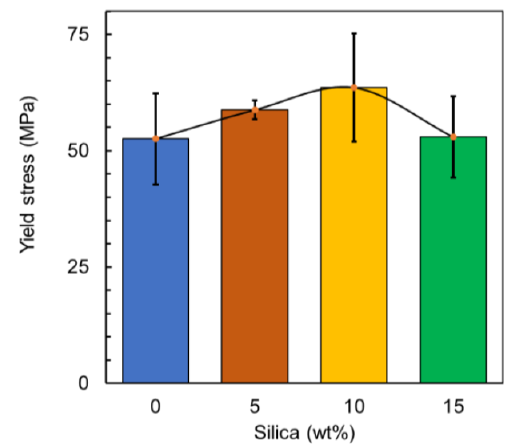
Figure 15. Yield stress of the prepared material. Table 1. The mechanical properties of the PLA/silica mixture with standard deviation (SD).